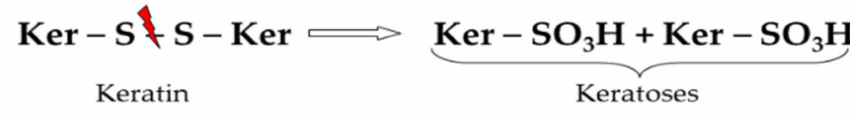
Figure 1. Oxidation of keratin into cysteic acid residues